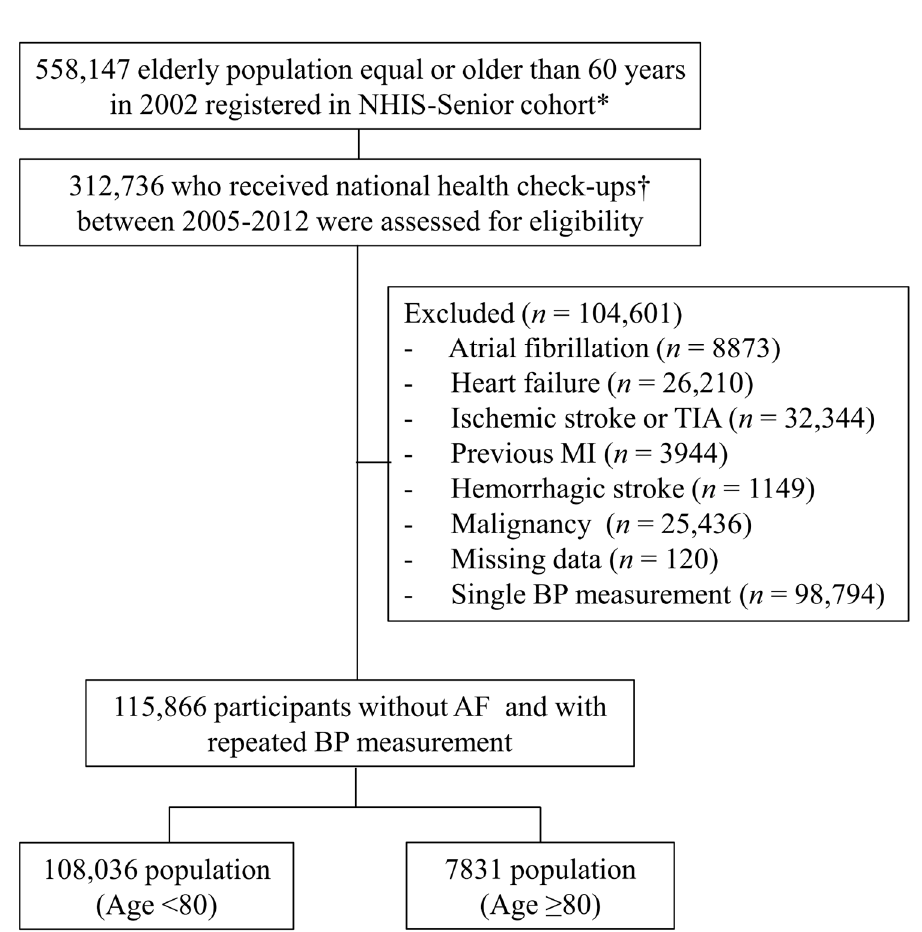
Figure 1. Flowchart of the study population enrollment and analyses. NHIS, National Health Insurance Service; TIA, transient ischemic attack; MI, myocardial infarction; BP, blood pressure; AF, atrial fibrillation. * Korean National Health Insurance Service (NHIS)-Senior cohort. † Complete checkup includes smoking, physical activity, alcohol, BMI, Total cholesterol, blood pressure, fasting glucose.